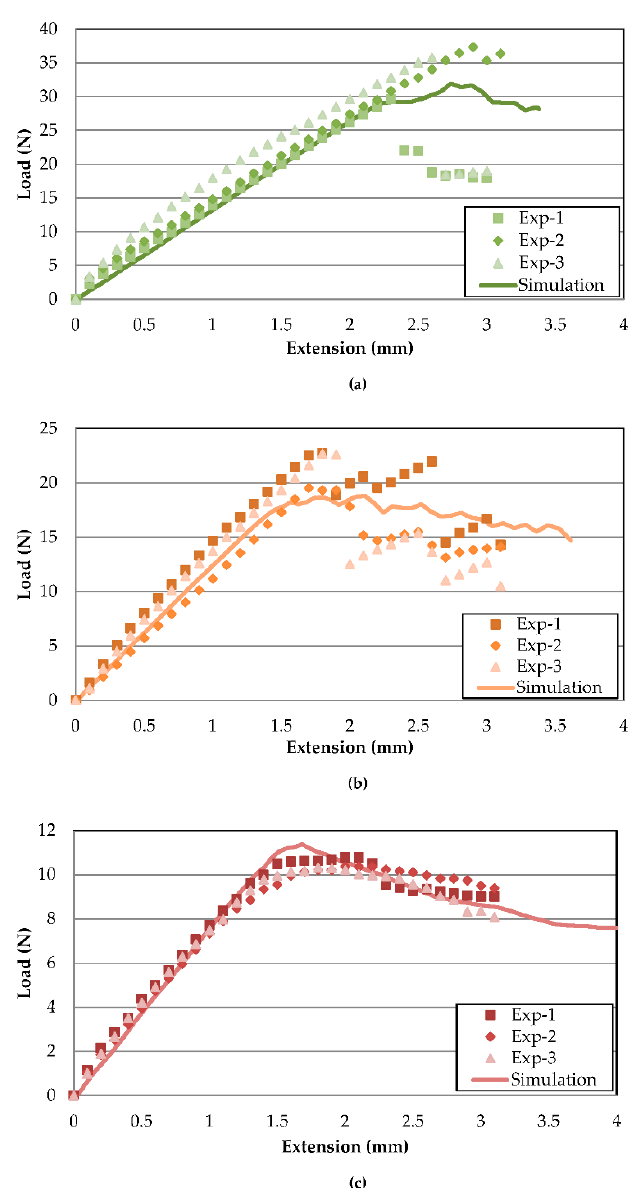
Figure 5. Mode-I load–displacement curve validation between experiment and simulation at ( a ) 30, ( b ) 70 and ( c ) 110 °C. Table 5. Mode-I slope and peak load data comparison between experimental and simulation re- sults.